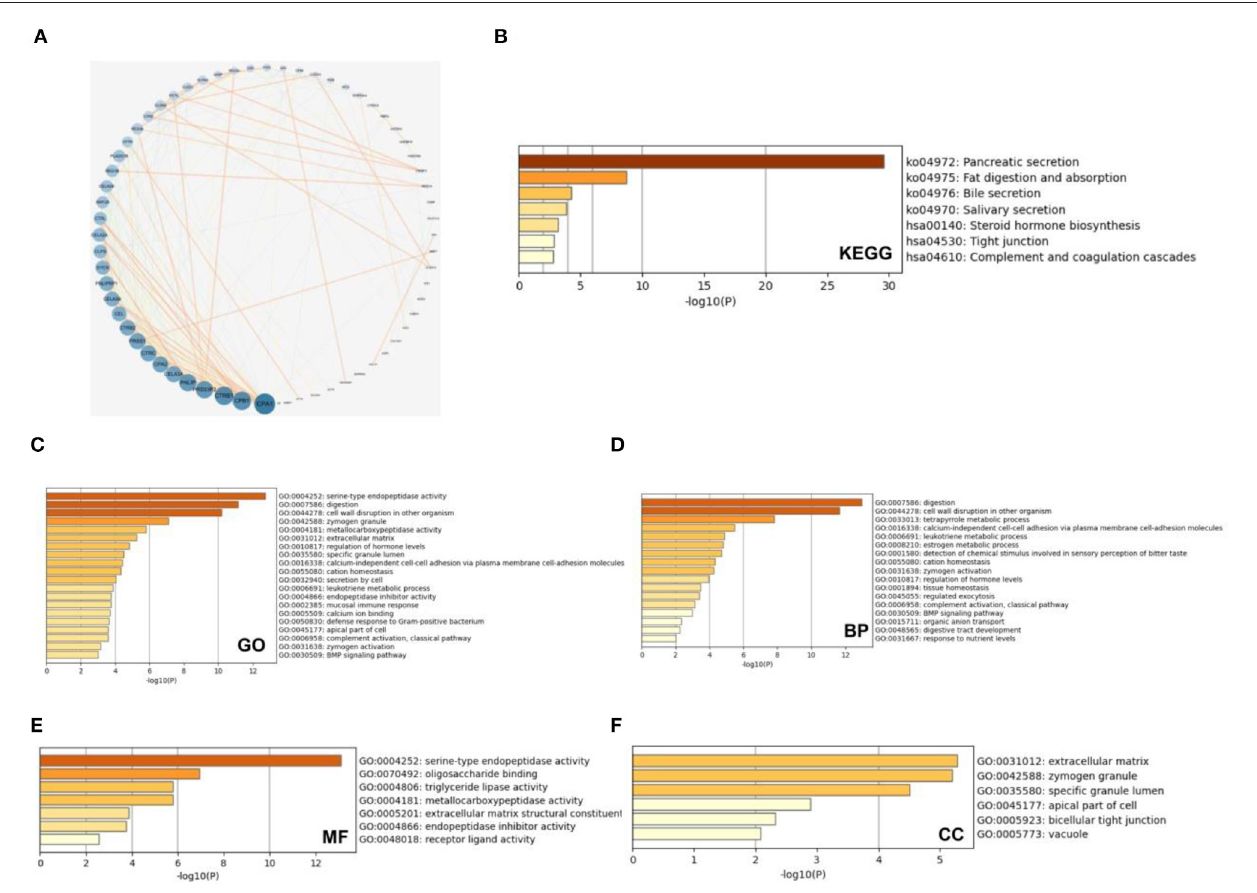
FIGURE 4 | Enrichment analysis of SMC gene family and neighboring genes in PAAD tissues. (A) Gene—gene interaction network between SMC family genes and 132 co-expressed genes. (B) KEGG analysis of SMC family genes and co-expressed genes and (C) GO analysis of these genes based on (D) biological processes (BP), (E) molecular function (MF), and (F) cellular component